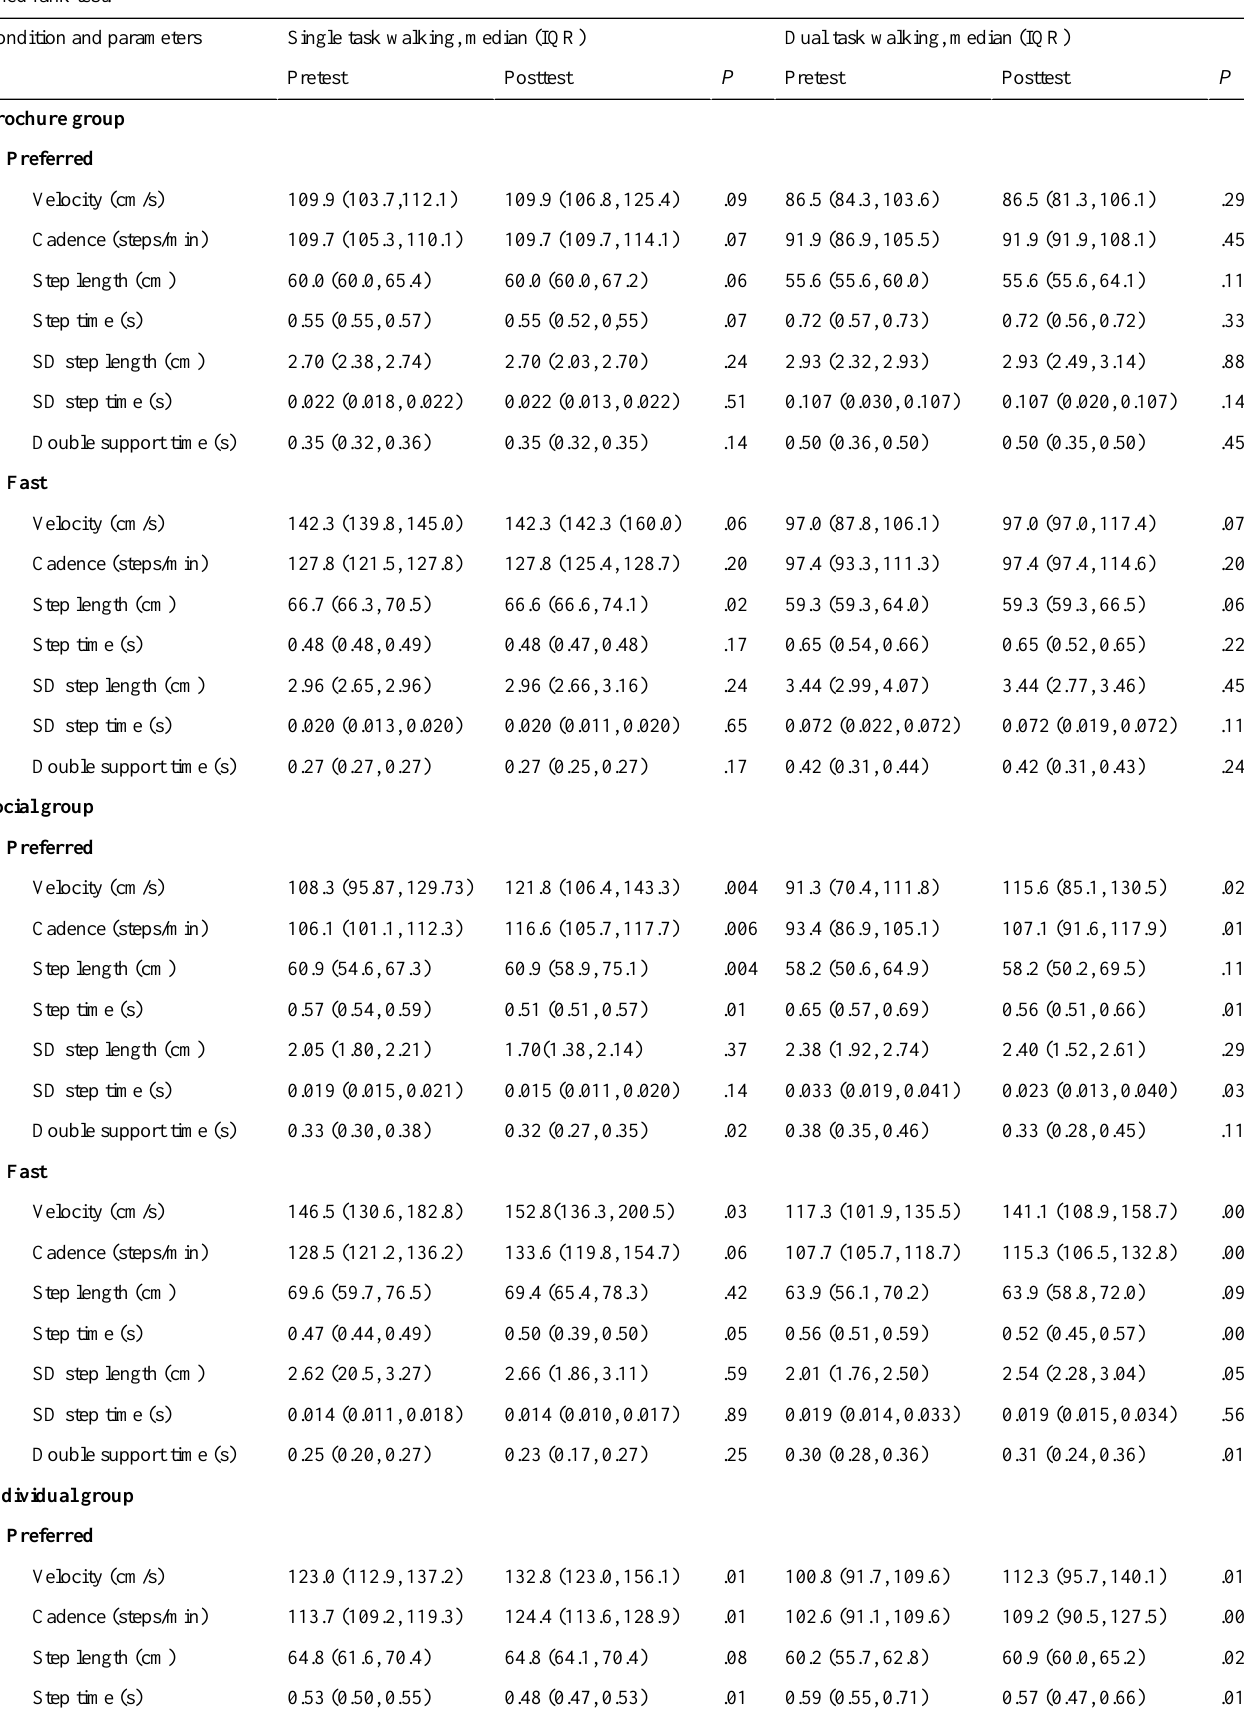
Table 3. Participants’single and dual task walking performance during the pretests and posttests and within-group significance calculated with Wilcoxon signed rank